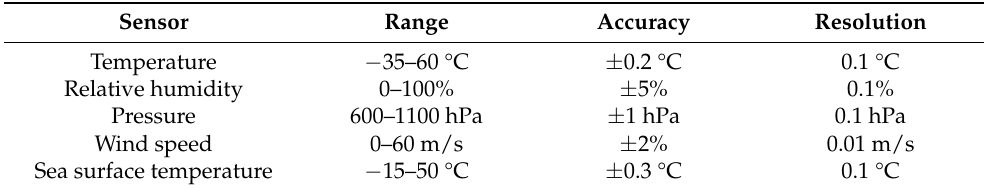
Figure 2. Geographical location of the offshore buoy and sensor location.